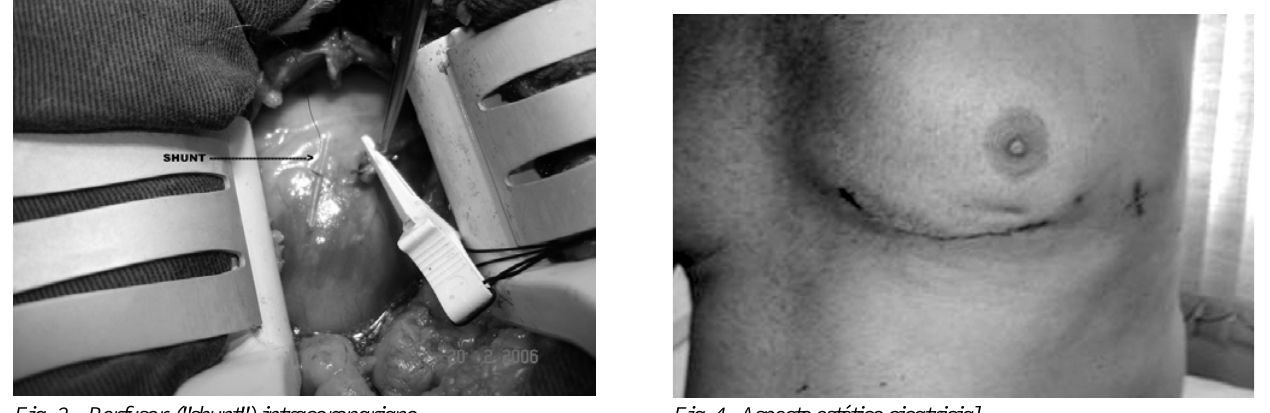
Fig. 4 - Aspecto estético